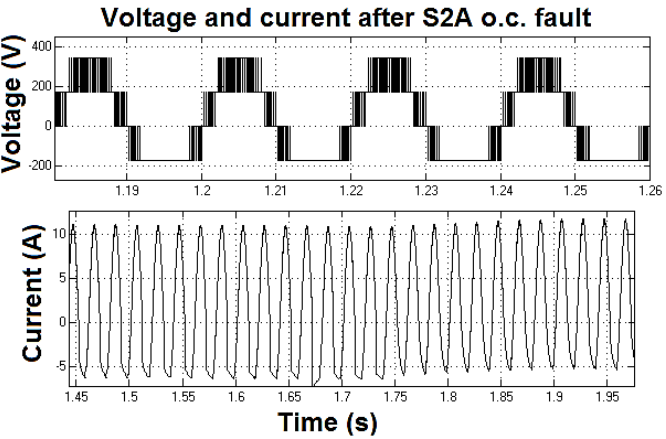
Figure 5. Load current and voltage waveform analysis of Bridge—A of S2A during an open-circuit fault.